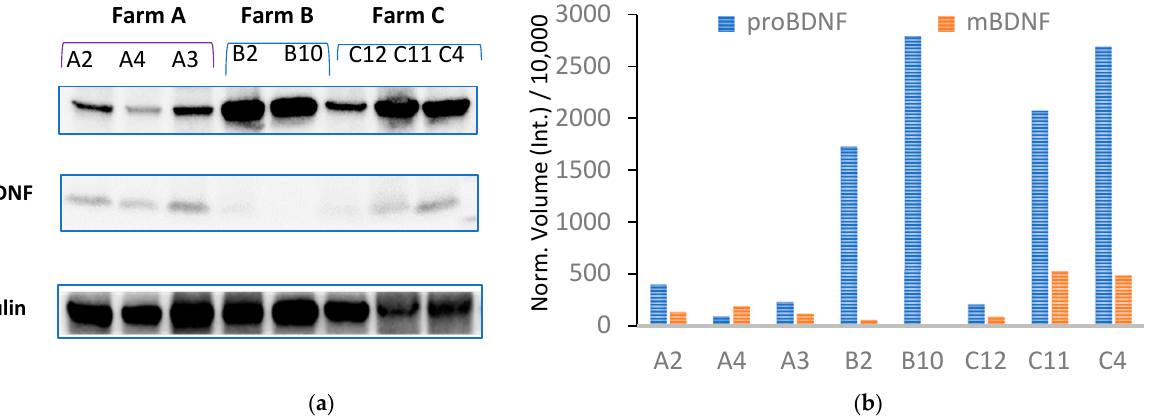
Figure 4. ( a ) Western blot analysis of hippocampal homogenate from Farm A cows (lanes A1, A4, A3), Farm B cows (lanes B2 and B10), and Farm C cows (lanes C12, C11, and C4) was performed to measure the expression of mBDNF and pro-BDNF. ( b ) Expression of proBDNF and mBDNF is shown as normalized volume against bovine β -tubulin used as a housekeeping gene.